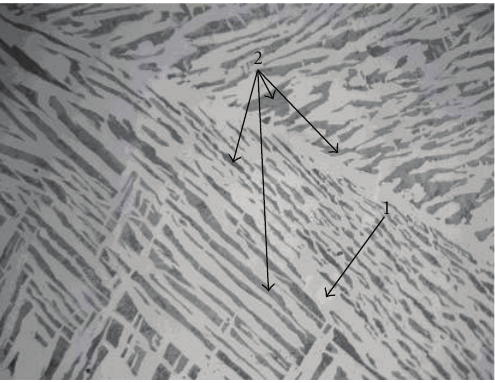
Figure 3: Optical micrograph ( × 200) showing the matrix (1) and pearlite (2).